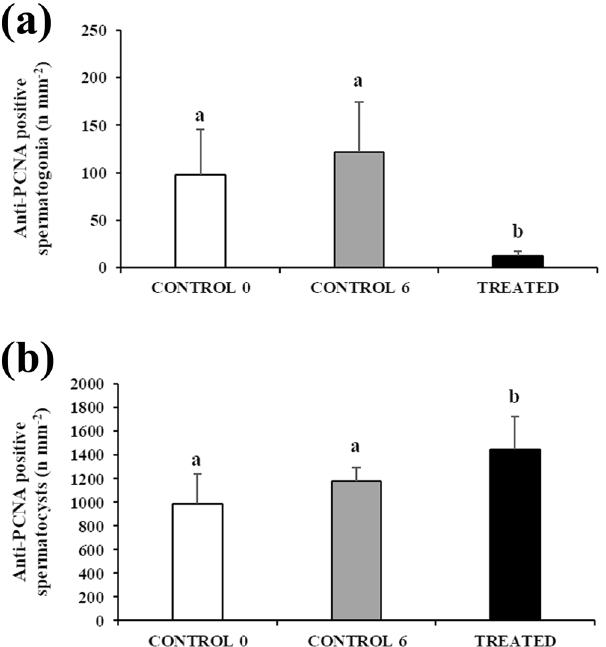
Figure 6. Changes in mean (± sd) anti-proliferating cell nuclear antigen (PCNA) positive germ cell density in untreated (CONTROL 0, n = 5), treated with saline solution for 6 weeks (CONTROL 6, n = 9) or treated with rFsh for 6 weeks (TREATED, n = 4) juvenile meagre males. ( a ) Anti-PCNA positive single A spermatogonia. ( b ) Anti-PCNA positive spermatocysts. Different letters represent statistically significant differences (ANOVA; P <